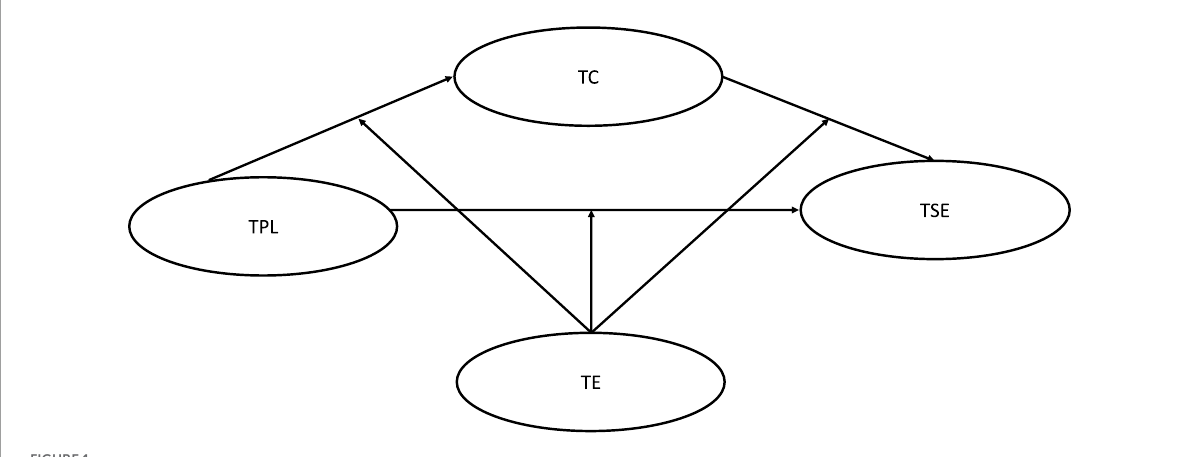
FIGURE1 Structure of the proposed model. TPL, Teacher-perceived principal leadership; TC, Teacher collaboration; TE, Teaching experience; TSE, Teacher self-efficacy.